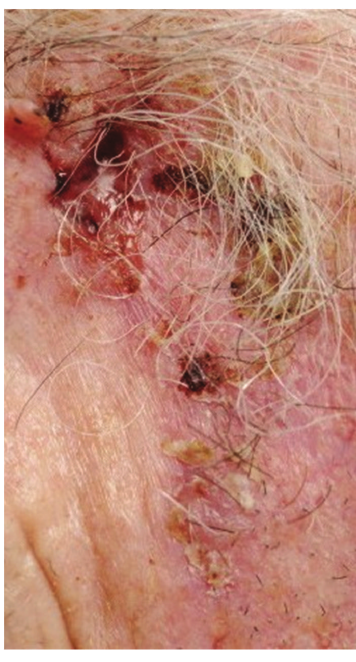
Figure 3: Morphoeic